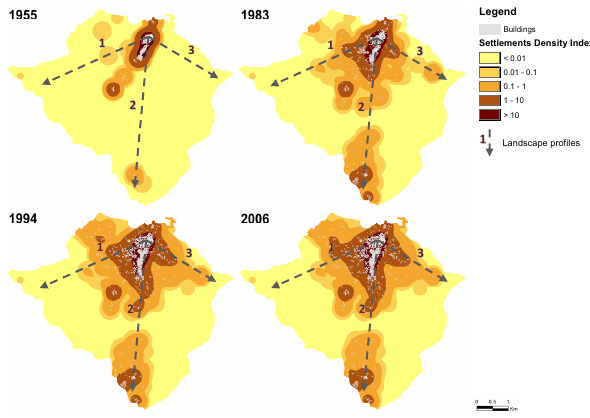
Fig. 9. Maps of the Settlement Density Index (SDI) calculated using Figure 9. Maps of the Settlement Density Index (SDI) calculated using Kernel Density 3 Kernel Density Estimation (KDE) for all time intervals investigated. Estimation (KDE) for all time intervals investigated. In each map, a localisation of the three 4 In each map, a localisation of the three defined profiles is shown defined profiles is shown (Profile 1: direction 251°, length 5 Km - Profile 2: direction 186°, 5 (Profile 1: direction 251 ◦ , length 5km – Profile 2: direction 186 ◦ , length 6 Km - Profile 3: direction 118°, length 3.5 Km). 6 length 6km – Profile 3: direction 118 ◦ , length